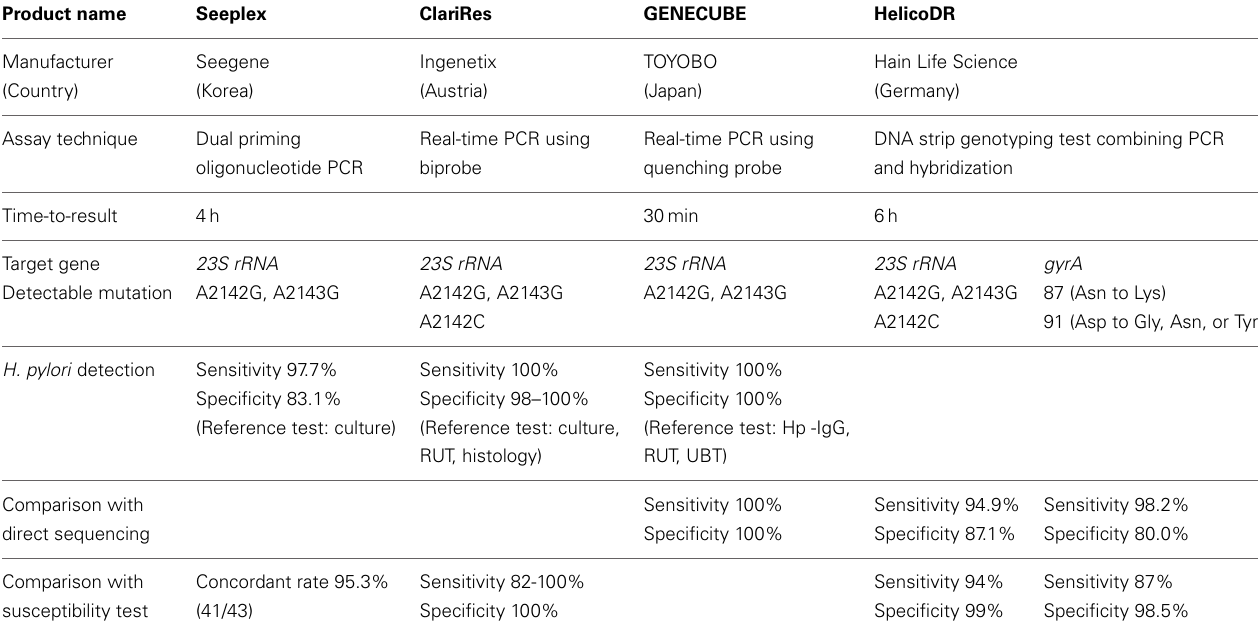
Table 1 | Commercially available molecular methods for H. pylori antibiotics